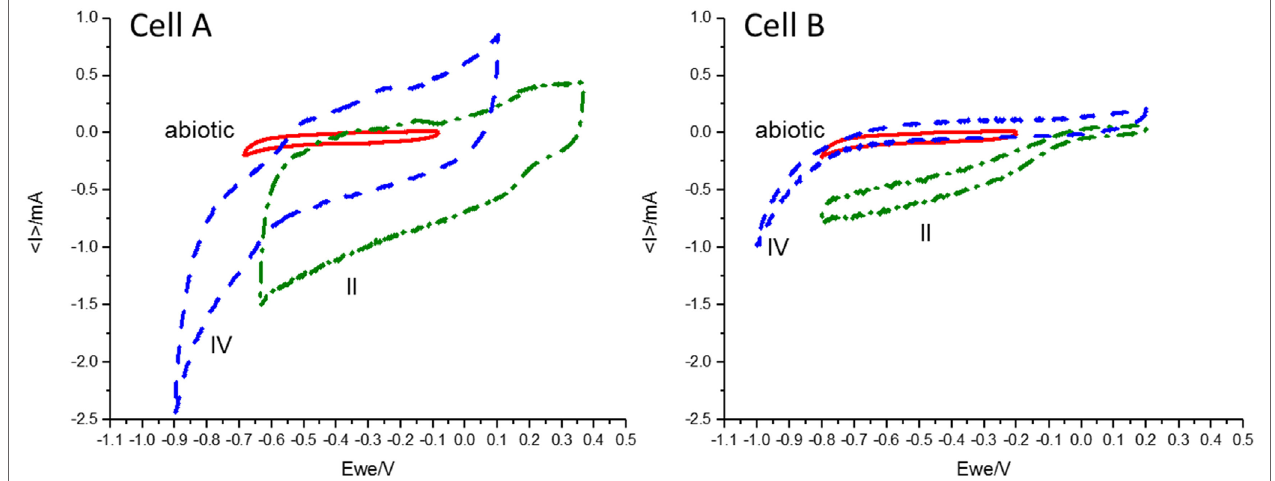
FigUre 1 | Cyclic voltammetry results performed in the abiotic control (red, solid line), the second period (II, green dashed-dotted line) and the fourth period (IV, blue dashed line) for cells A and B at a scan rate of 1 mV/s under turnover conditions. Differences in the catalytic current for the different periods and between cells A and B at each potential can be